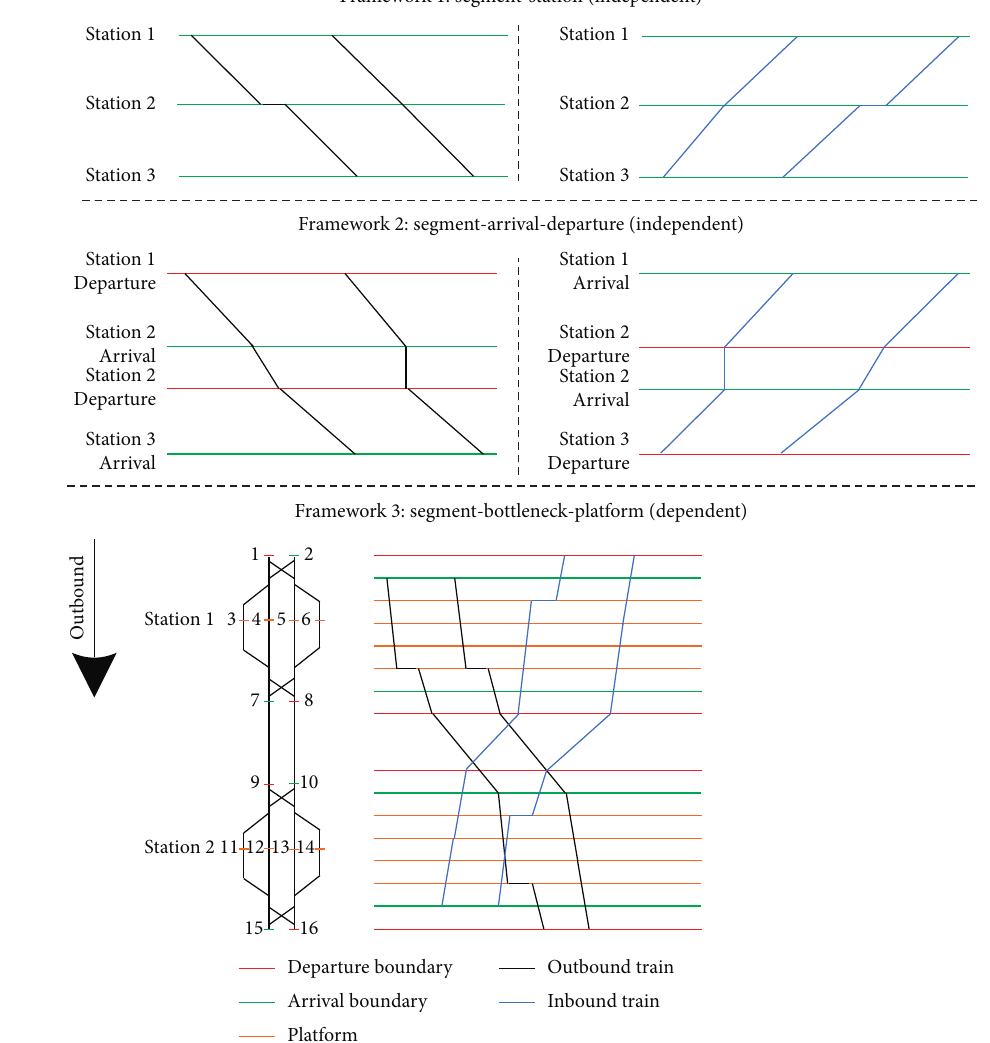
Figure 2: Three railway network